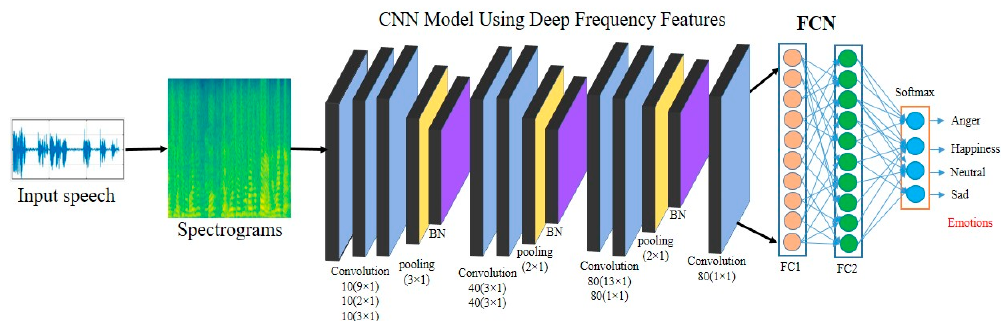
Figure 3. An overview of the proposed speech emotion recognition (SER) model: We proposed new plain rectangular shape fitters with a modified pooling strategy to learn and capture the deep frequency features from the speech spectrogram. Table 1. The overall specification of the proposed model is illustrated with set of convolutions layers, input and output size, and number of units which consist of kernel size, and number of parameters. Model Layers